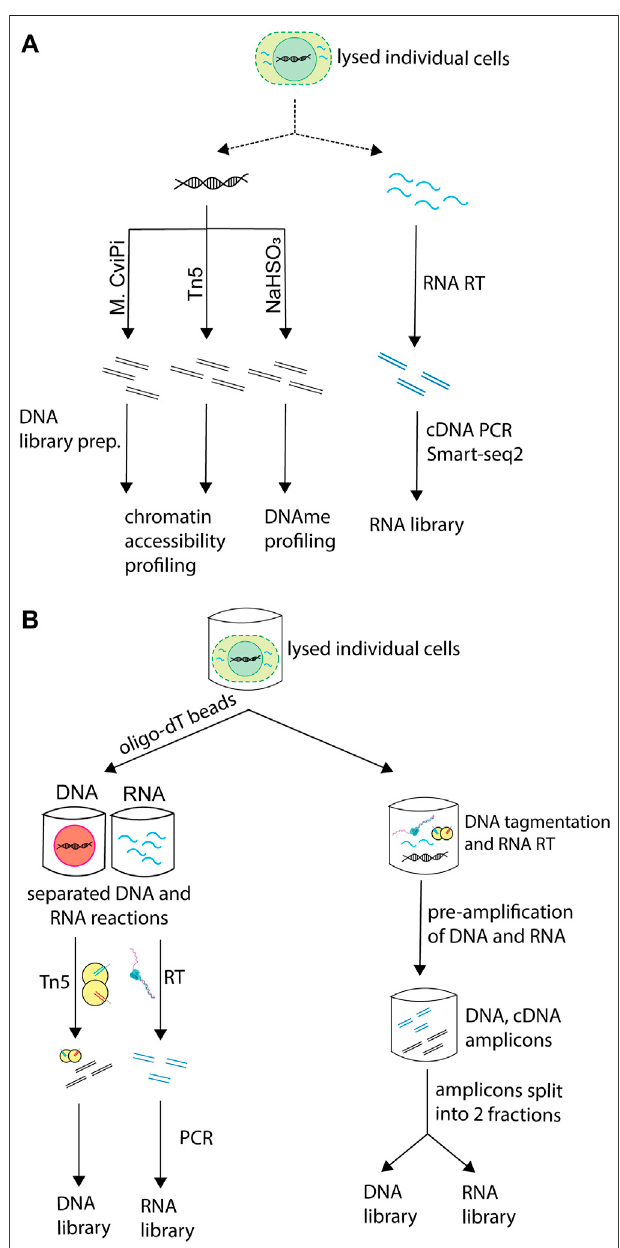
FIGURE 2 | Processing of different molecular layers in sc-multiomics. Single-cell multiomics techniques that simultaneously pro fi le the genome and transcriptome of cells differ in the way they process these molecules. (A) Different types of processing of DNA and RNA employed in sc- multiomics depending on the goal of the technique. sc-multiomics techniques differ in the way they process DNA and/or RNA, depending on what the approach aims to pro fi le: DNA can be either treated with M. CviPI (a DNA methyltransferase that methylates cytosine in accessible GC dinucleotides) or withTn5(iftheaimistocharacterizechromatinstatus),orbisul fi teconverted(if the aim is DNA methylation pro fi ling), while RNA is subjected to RT and ampli fi cation. (B) Simultaneous or parallel processing of DNA and RNA in sc- multiomics.Insc-multiomics,onceindividualcellsarelysed,either1)DNAand RNA can be fi rst separated from each other using oligo-dT beads and then processed in parallel (left), or 2) the lysed cell can be subjected to DNA